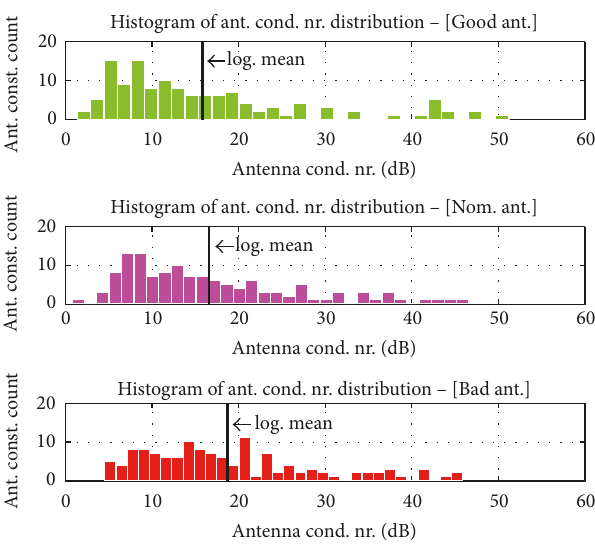
Figure 18: Distribution of the antenna condition number and mean logarithmicconditionnumberofthe“Good”;“Nominal”;and“Bad” reference